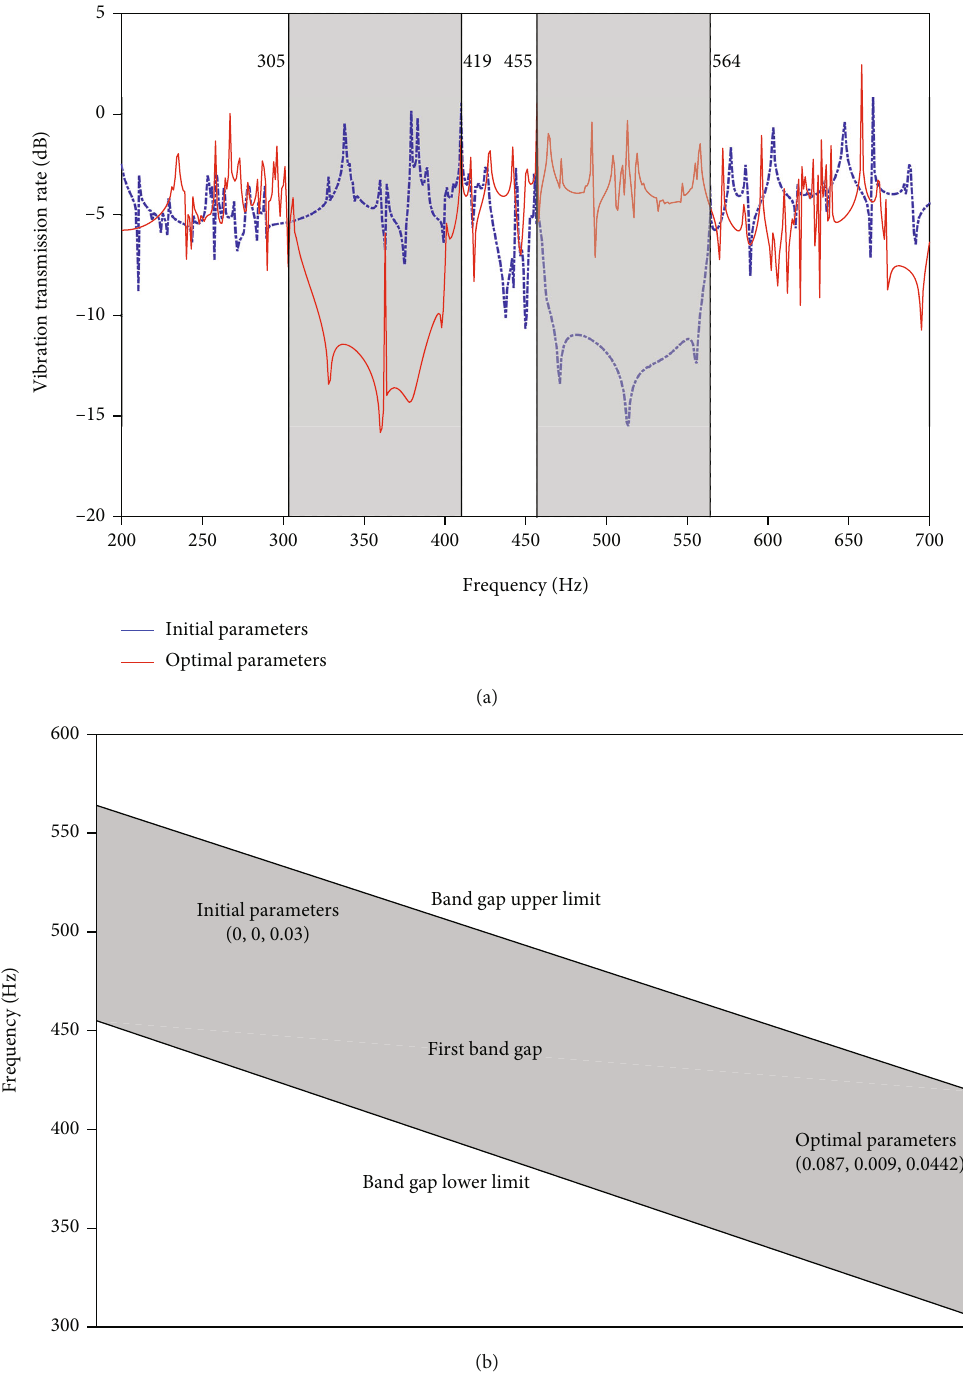
Figure 17: Corresponding to initial parameters and optimal parameters: (a) vibration transmission rate of node R ; (b) the fi rst band